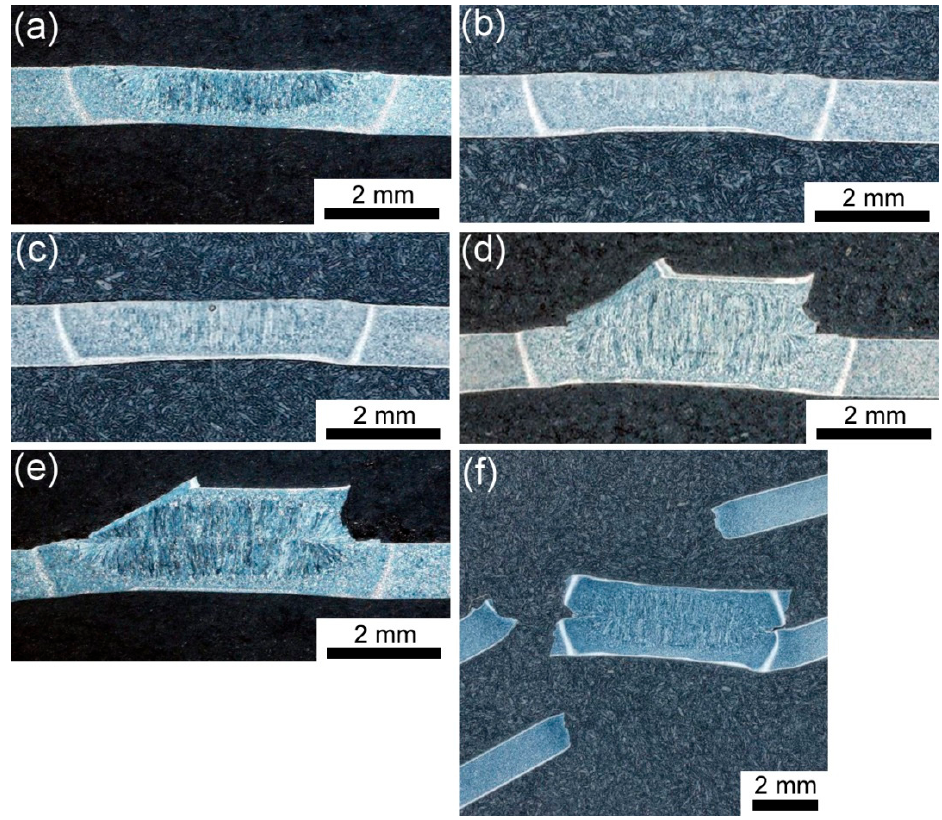
Figure 17. Macrostructures showing failure mode at weld current of ( a ) 5.0 kA in the one-step RSW; ( b ) 5.0 kA in the two-step RSW; ( c ) 5.5 kA in the one-step RSW; ( d ) 5.5 kA in the two-step RSW; ( e ) 6.0 kA in the one-step RSW; ( f ) 6.0 kA in the two-step RSW.